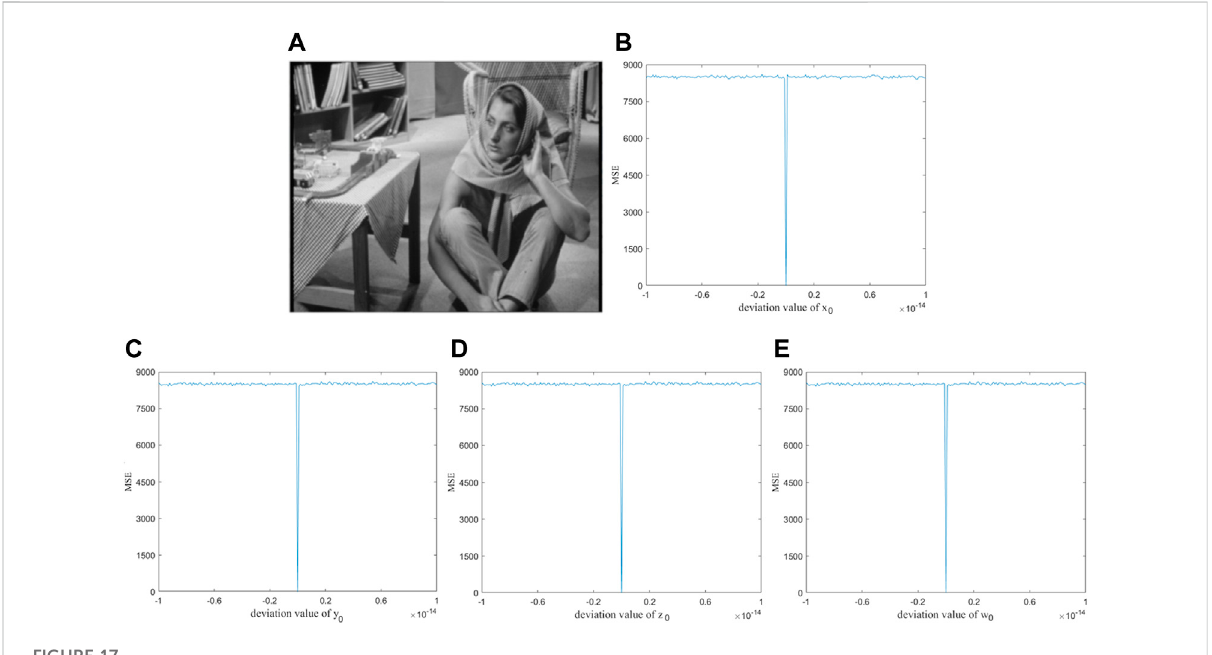
FIGURE 17 (A) Plaintext image, MSE curves: (B) x 0 , (C) y 0 , (D) z 0 , (E) w 0 .